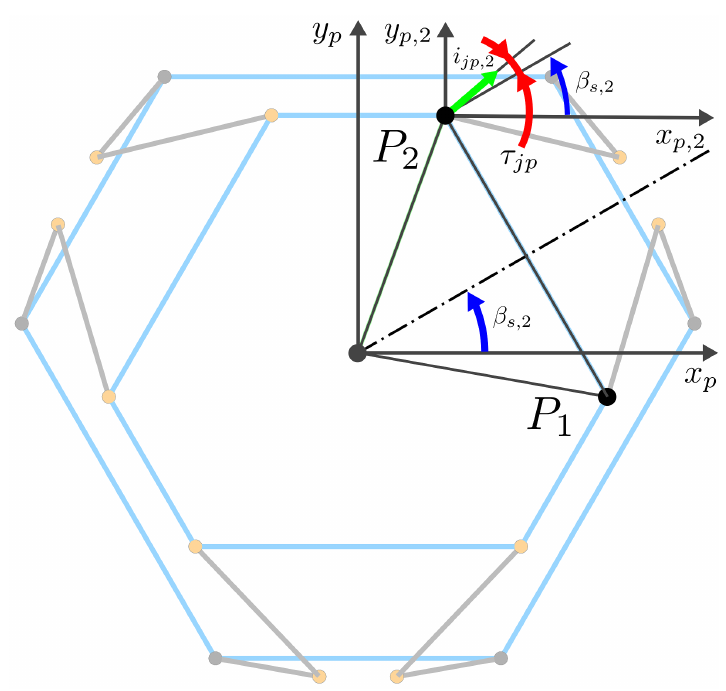
Figure 8. Axes of platform and upper lever